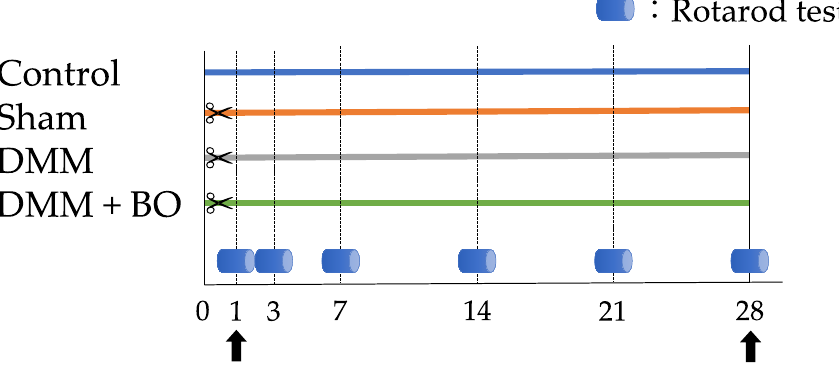
Figure 1. Protocol of Experiment 1. Twenty 12-week-old rats were divided into the following four groups: control, sham, DMM, and DMM + BO. During 28 days after DMM or sham surgery, the rotarod test was performed before and 1, 3, 7, 14, 21, and 28 days after DMM surgery. The spinal cord at the L2–L4 level was harvested for immunofluorescence staining and Western blotting on days 1 and 28 after the surgery. DMM, destabilization of the medial meniscus; BO, boiogito.